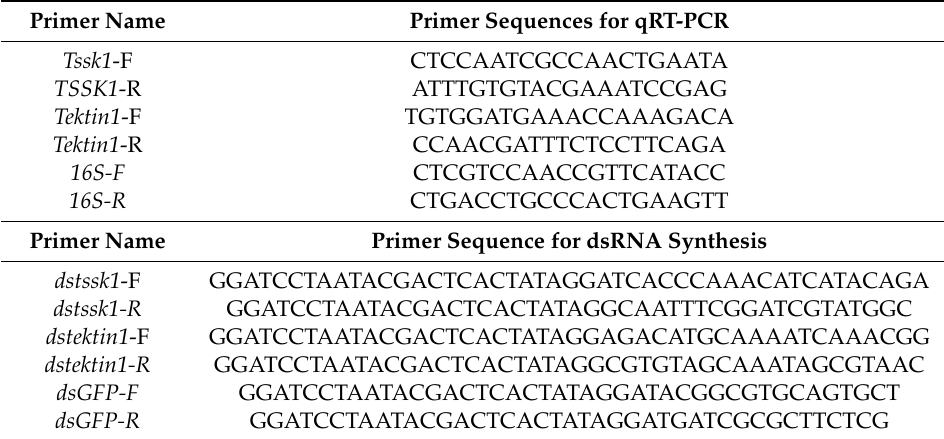
Table 1. Primer used for gene expression analysis and RNA interference